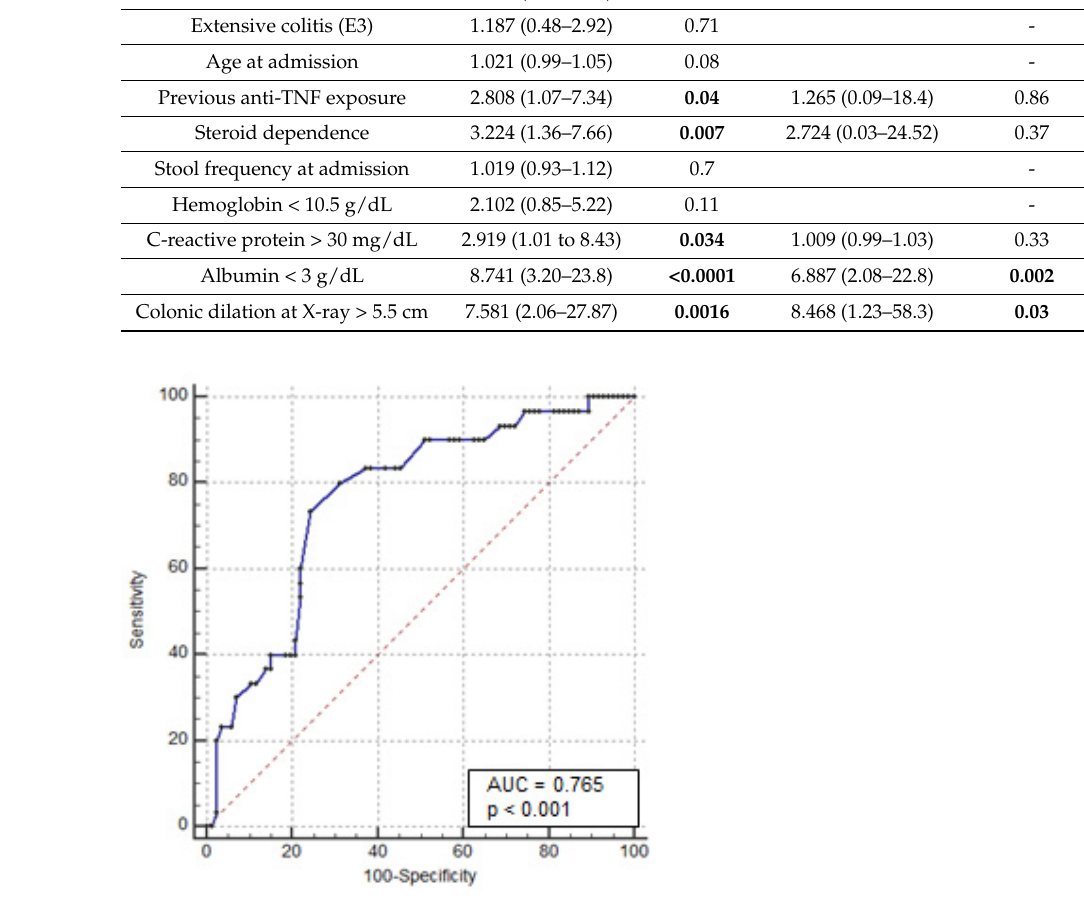
Figure 2. Receiver operating characteristic curves for colectomy based on the serum albumin levels at admission.